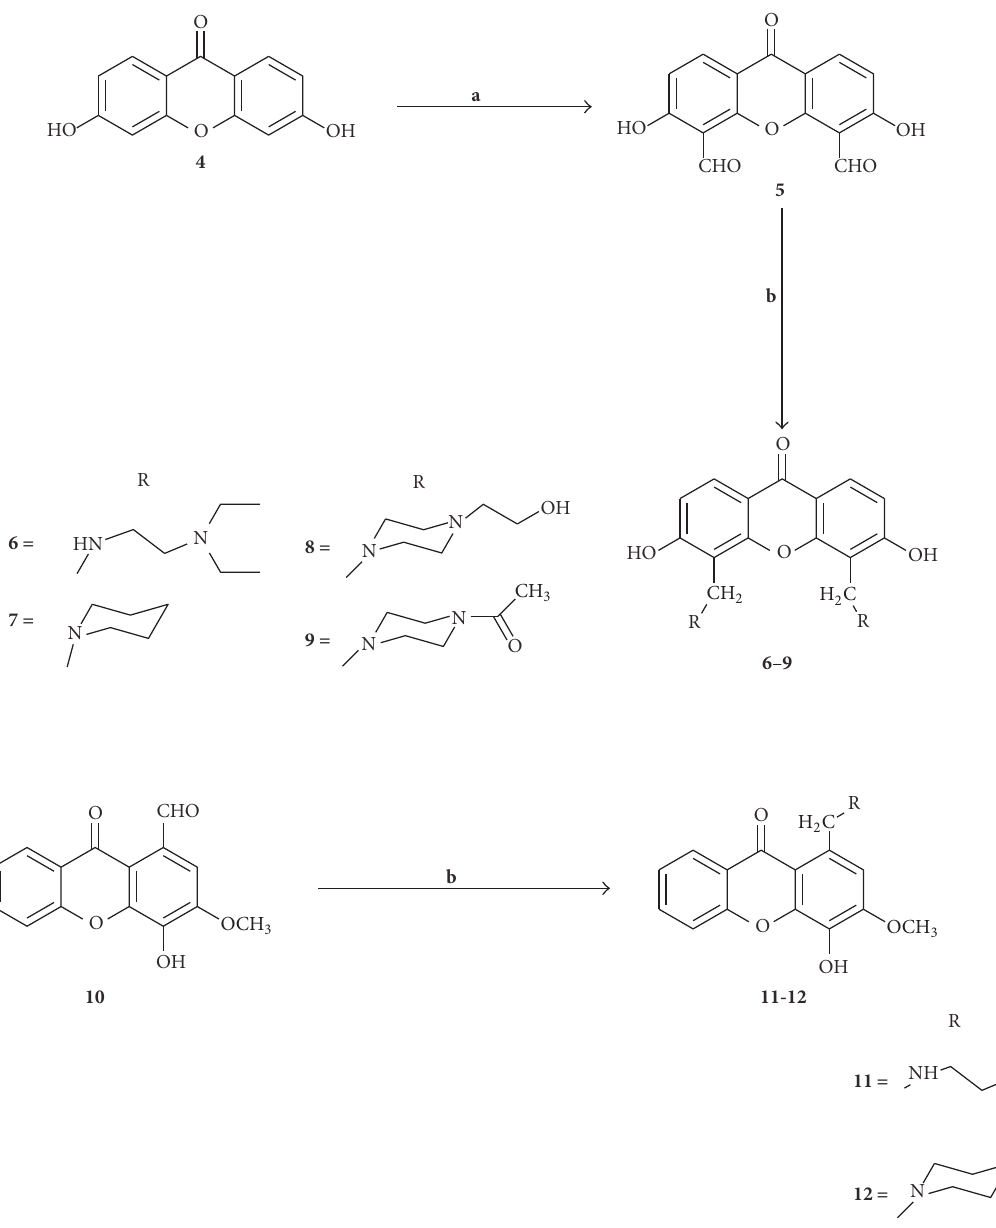
Scheme2:Reagentsandconditionsforthesynthesisofcarbaldehydexanthone 5 andaminatedxanthones 6 – 9 and 11 - 12 .( a